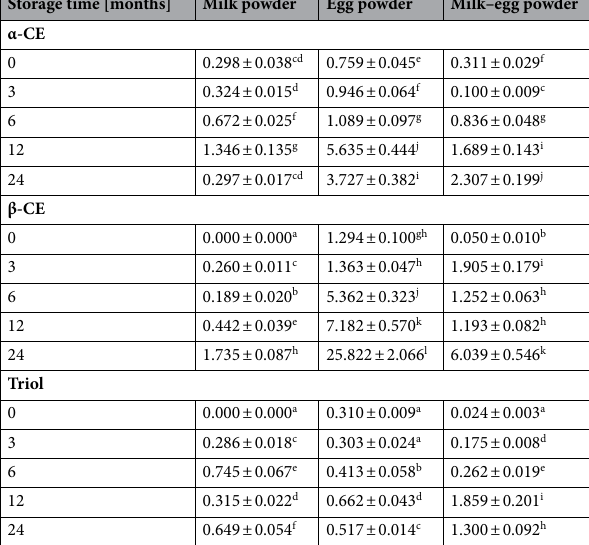
Table 5. Content (µg g −1 powder) of α-CE, β-CE and triol in powders. a,b —different letters within the column denote statistically significant differences between the results (P < 0.05); ± means